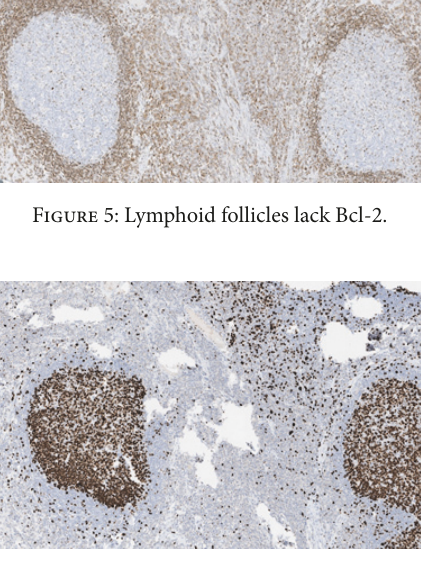
Figure 6: Lymphoid follicles exhibit high